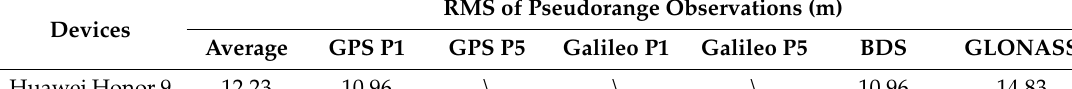
Table 2. The RMS of pseudorange observations of each mobile phone with di ff erent global navigation satellite systems (GNSS), where P1 and P5 denote pseudorange observations of two frequencies L1 / E1 and L5 /